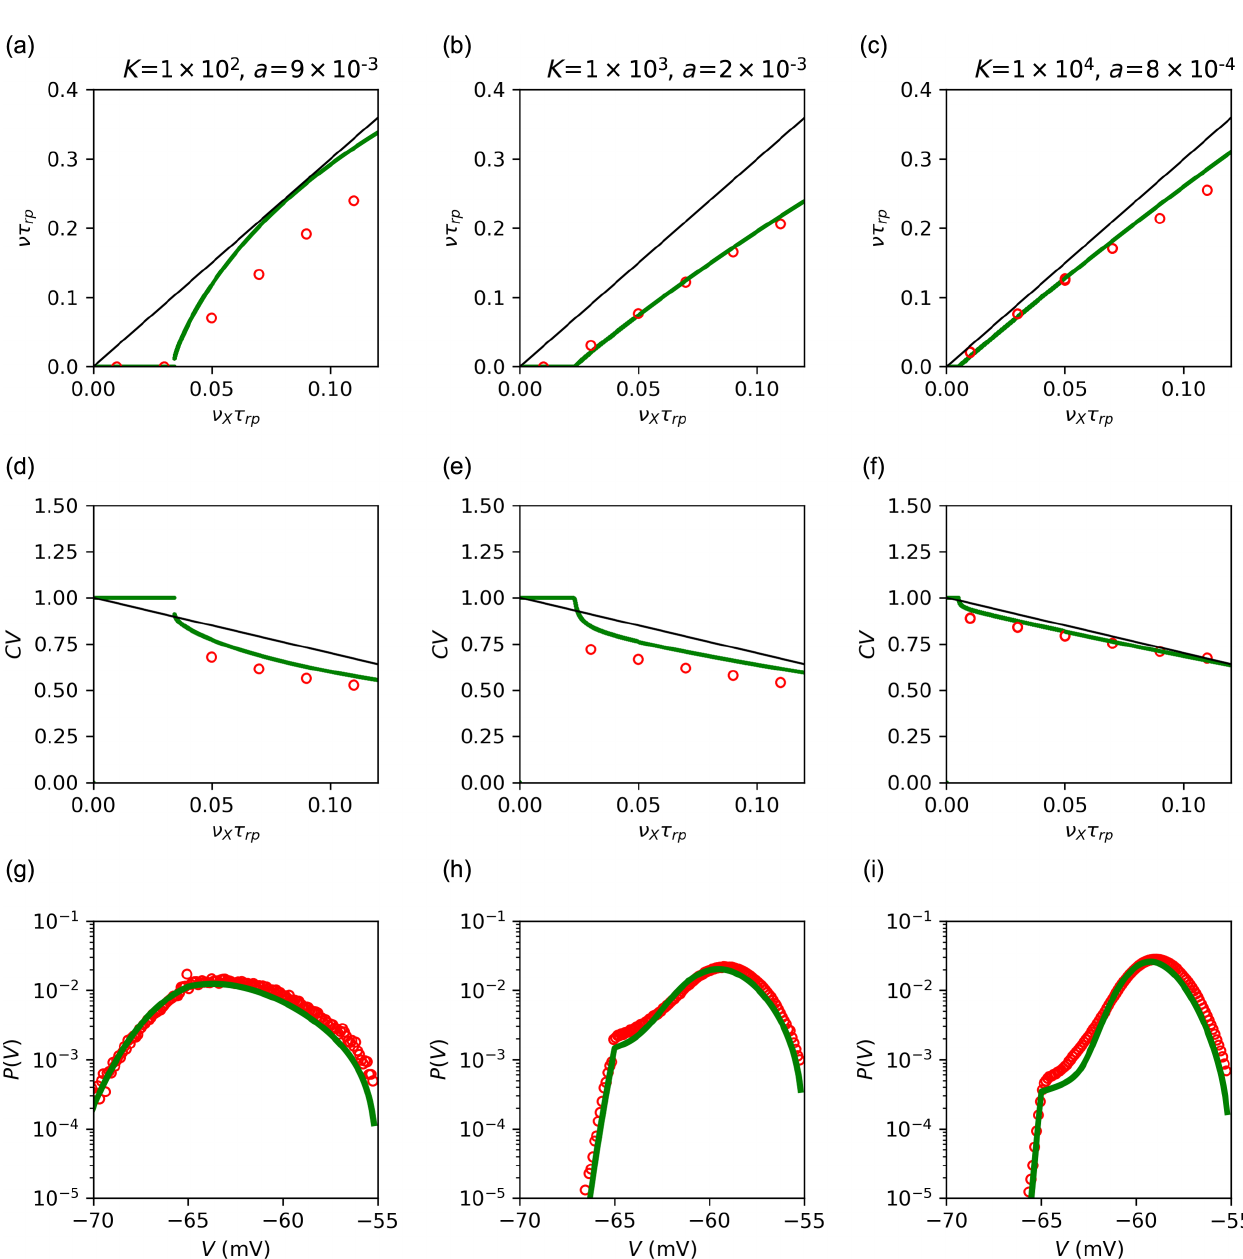
0 . 05 τ (third row). In each, we show the mean field E ¼ rp 100 K N N N E ¼ I ¼ EX ¼ IX ¼